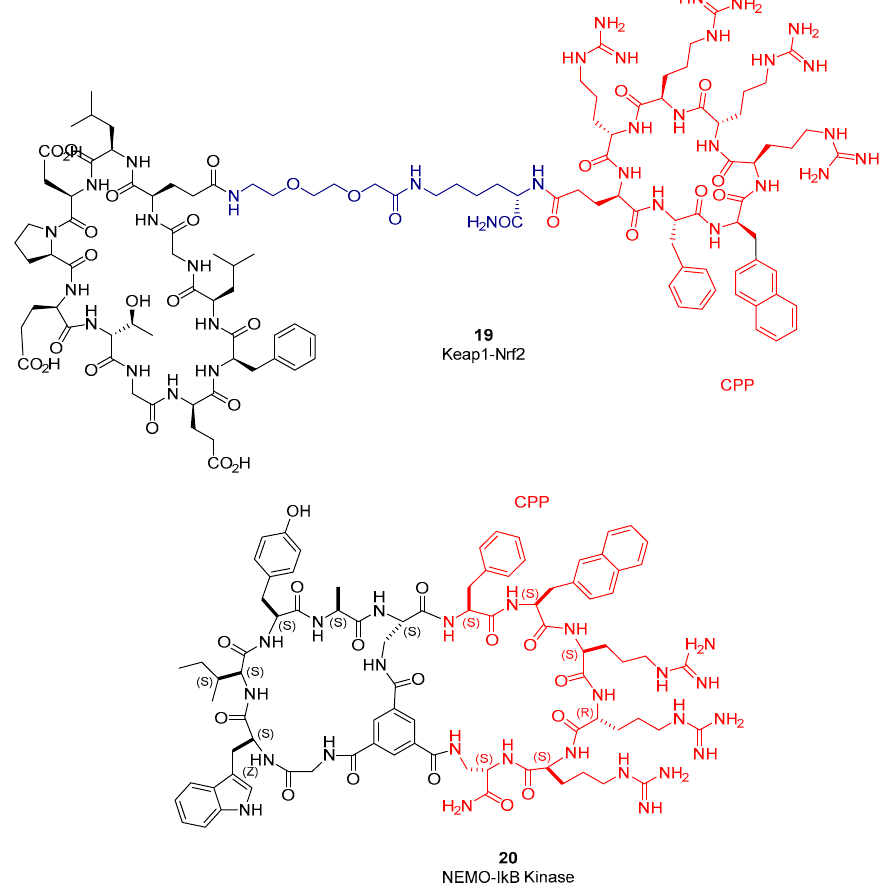
Figure 5. Selected examples of cell-penetrating peptide (CPP)–cyclic peptide conjugates and bicyclic-merged peptides.